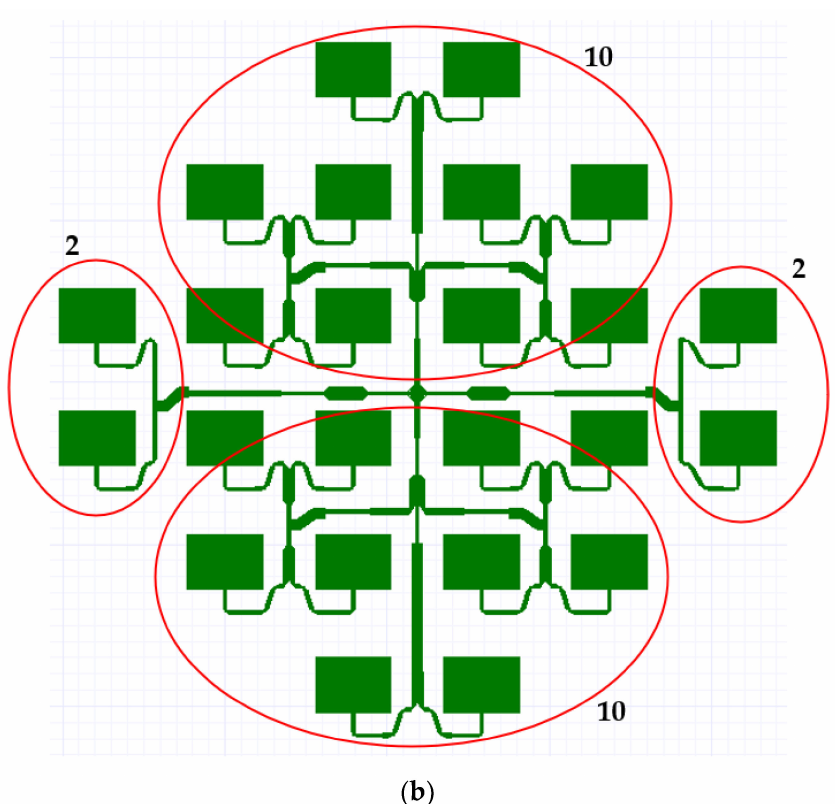
Figure 17. ( a ) Power division network for 1 to 2:10:10:2 power ratio, with ideal transmission lines. ( b ) Power division network for 1 to 2:10:10:2 power ratio. Microstrip radiators with microstrip transmission line transformers and the power values are indicated.